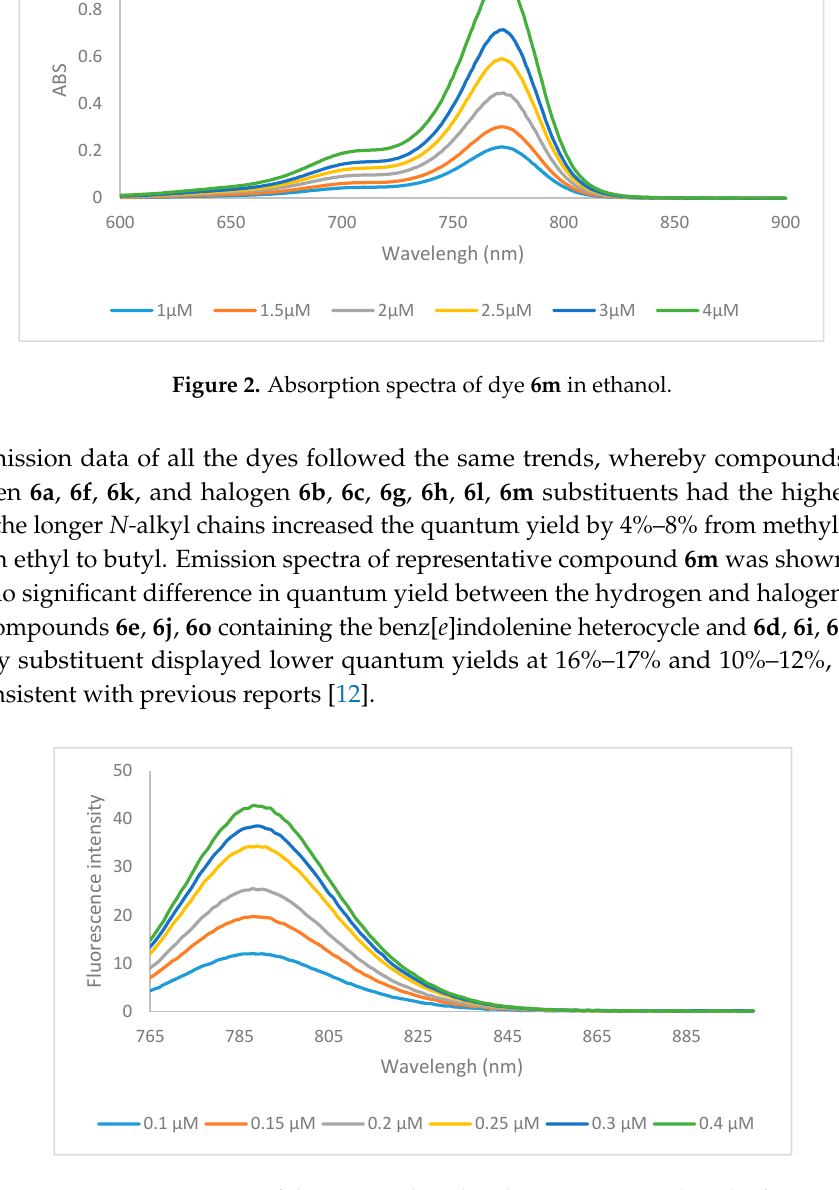
Figure 3. Emission spectra of dye 6m in ethanol with excitation wavelength of 750 nm.